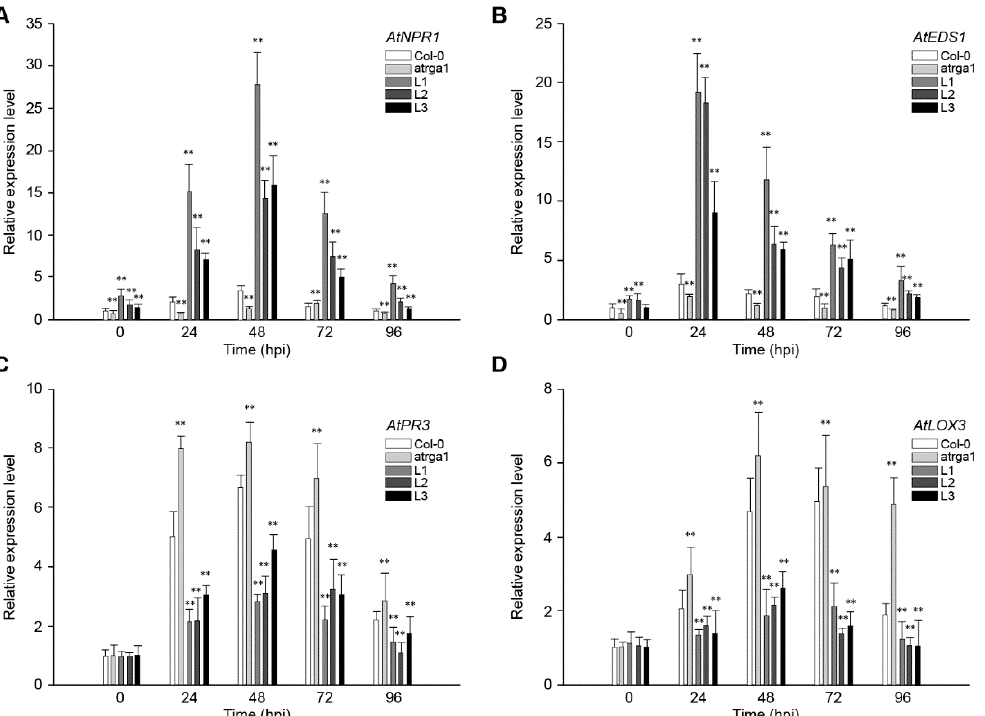
Figure 4. Assessment of the expression of defense-related genes at different time points after inoculating Hpa. Relative expression levels of ( A ) AtNPR1, ( B ) AtEDS1, ( C ) AtPR3, and ( D ) LOX3 were detected via qRT-PCR. Data represent mean values ± SD from three independent experiments. Asterisks show statistically significant differences (** p < 0.01, Student’s t test).